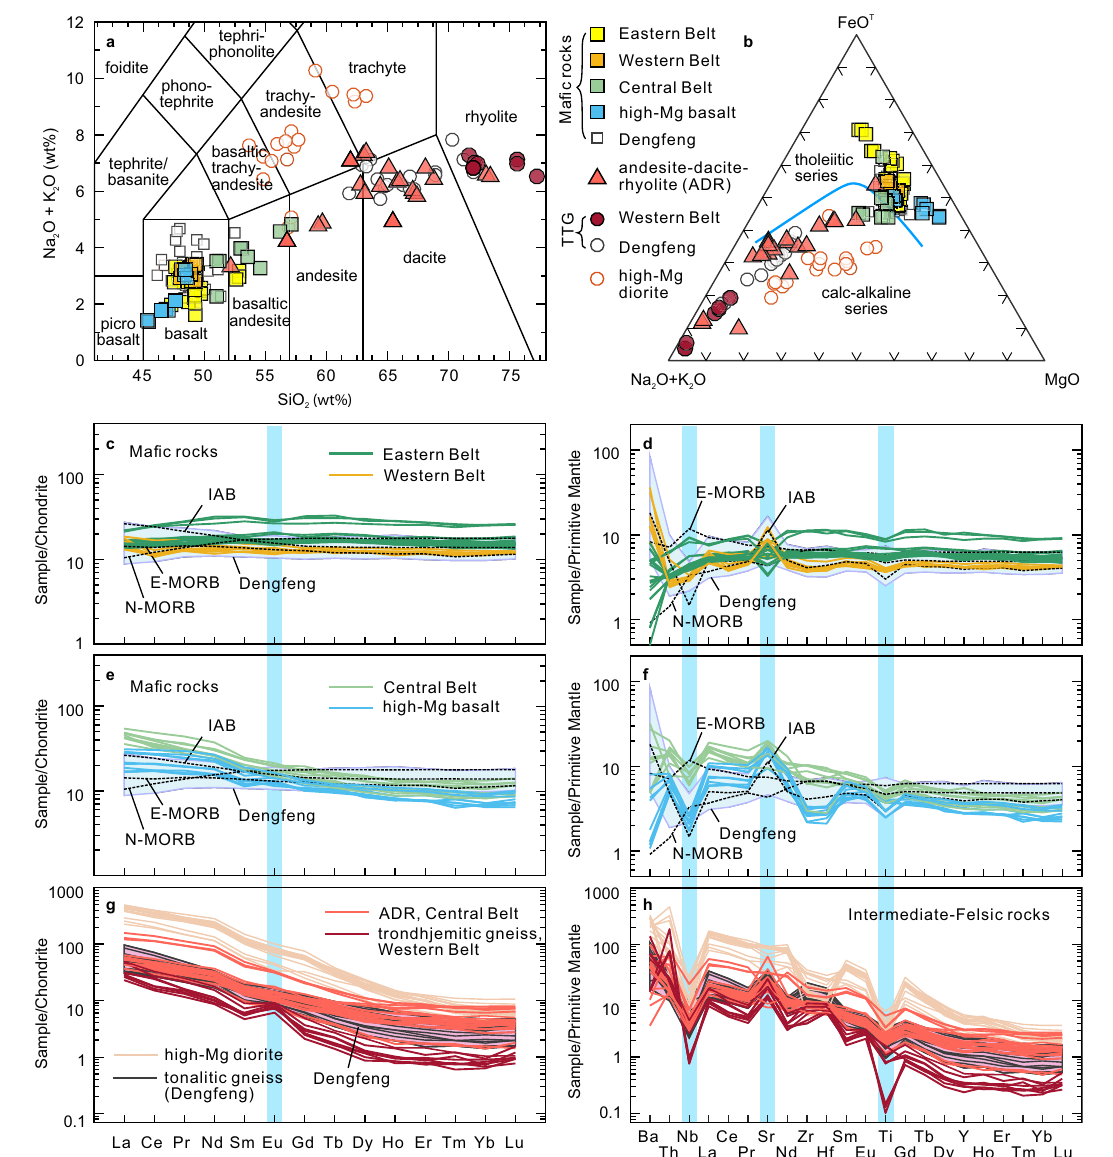
Fig. 2 | Major and trace element geochemical characteristics of the Angou Complex. a Na 2 O+K 2 O versus SiO 2 diagram. b AFM (Na 2 O+K 2 O – MgO – FeO T ) diagram. c , e , g Chondritenormalizedrareearthelementdiagrams. d , f , h Primitive mantle-normalized trace element diagrams. Results from the adjacent and coeval Dengfeng Complex that preserves pristine tonalitic TTG gneisses, high-Mg diorite